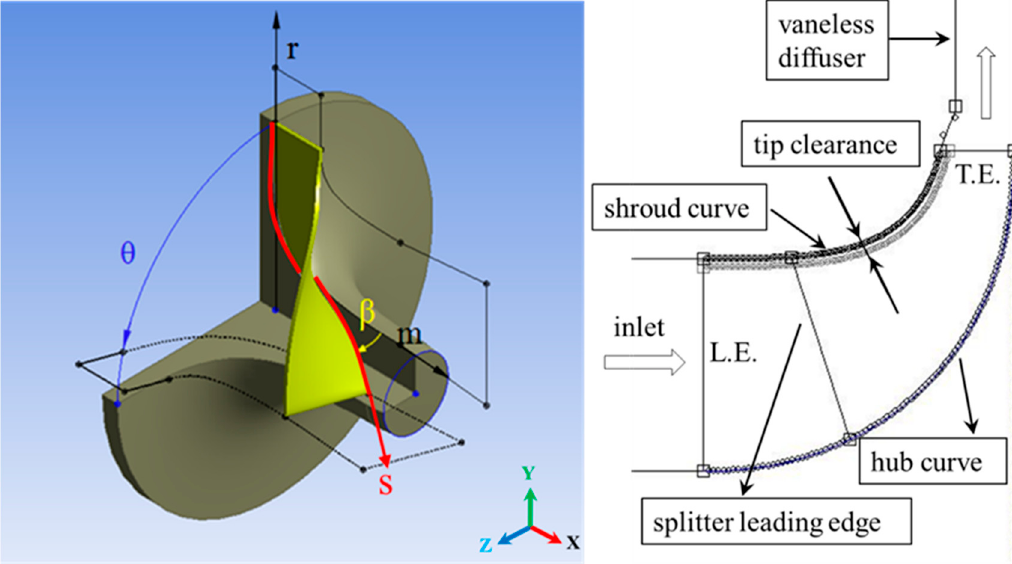
Figure 1. Definition of beta ( β ) distribution and the meridional contour of the impeller and location of splitter leading edge.